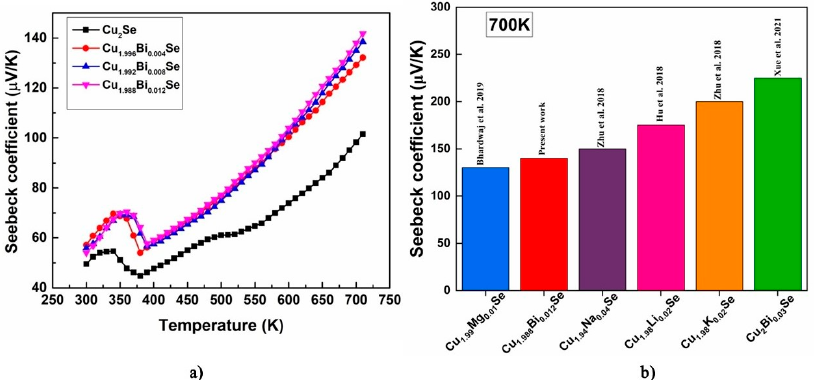
Figure 10. ( a ) Temperature-dependent Seebeck coefficient for Cu 2 − x Bi x Se (x = 0.00, 0.004, 0.008, 0.012) samples, ( b ) comparison of Seebeck coefficient of the synthesized composition with existing literature on Cu 2 Se with different dopants [2,16–18,27].